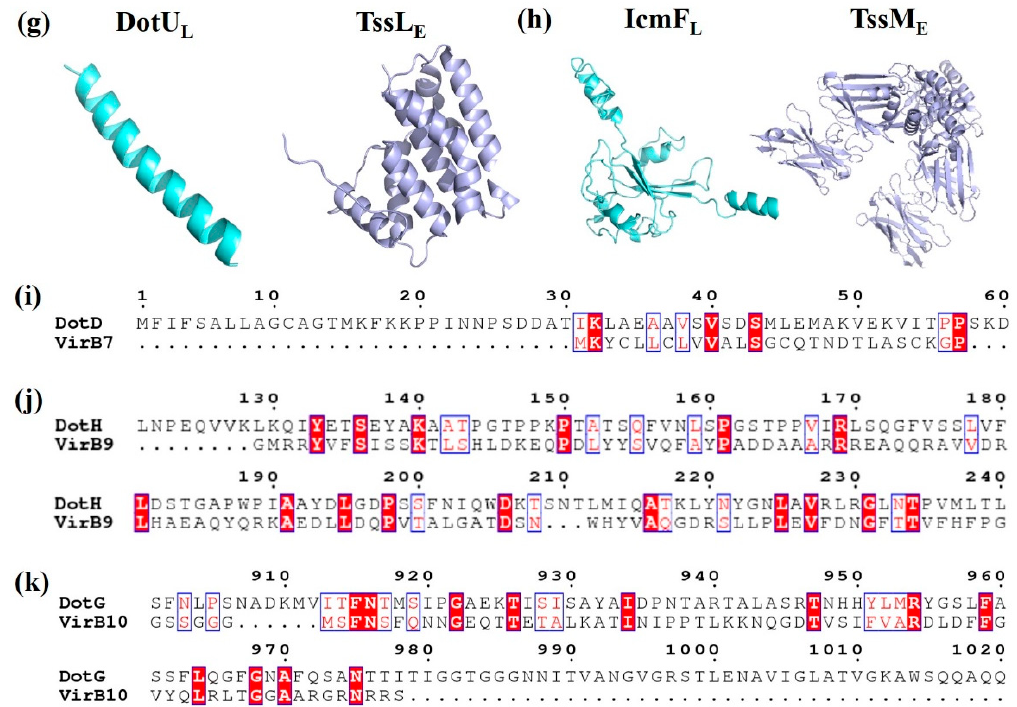
Figure 3. Crystal structure and amino acid sequences alignment of T4BSS proteins and their structural homologs. ( a ) ATPases of Legionella pneumophila DotB L (PDB id: 6GEB) , Agrobacterium tumefaciens VirB11 A , Vibrio fluvialis GspE V ; ( b ) Outer membrane proteins of L. pneumophila DotD L (PDB id: 3ADY), A. tumefaciens VirB7 A , Vibrio fluvialis GspD V , and Escherichia coli EscC (PDB id: 3GR5); ( c ) Periplasmic proteins of L. pneumophila DotH L , A. tumefaciens VirB9 A ; ( d ) Membrane-spanning proteins of L. pneumophila DotG L and A. tumefaciens VirB10 A ; ( e ) Inner membrane (IM)-associated proteins of L. pneumophila DotO L and A. tumefaciens VirB4 A ; ( f ) IM proteins of L. pneumophila DotI L and A. tumefaciens VirB8 A ; ( g ) Inner membrane proteins of L. pneumophila DotU L , and E. coli TssL E (PDB id: 3U66); ( h ) IM proteins of L. pneumophila IcmF L and E. coli TssM E (PDB id: 4Y7M); ( i ) N-terminal domain of L. pneumophila DotD L and A. tumefaciens VirB7 A ; ( j ) Residues 168–227 of L. pneumophila DotH L and N-terminal domain of A. tumefaciens VirB9 A ; ( k ) C-terminal domain of L. pneumophila DotG L and A. tumefaciens VirB10 A .